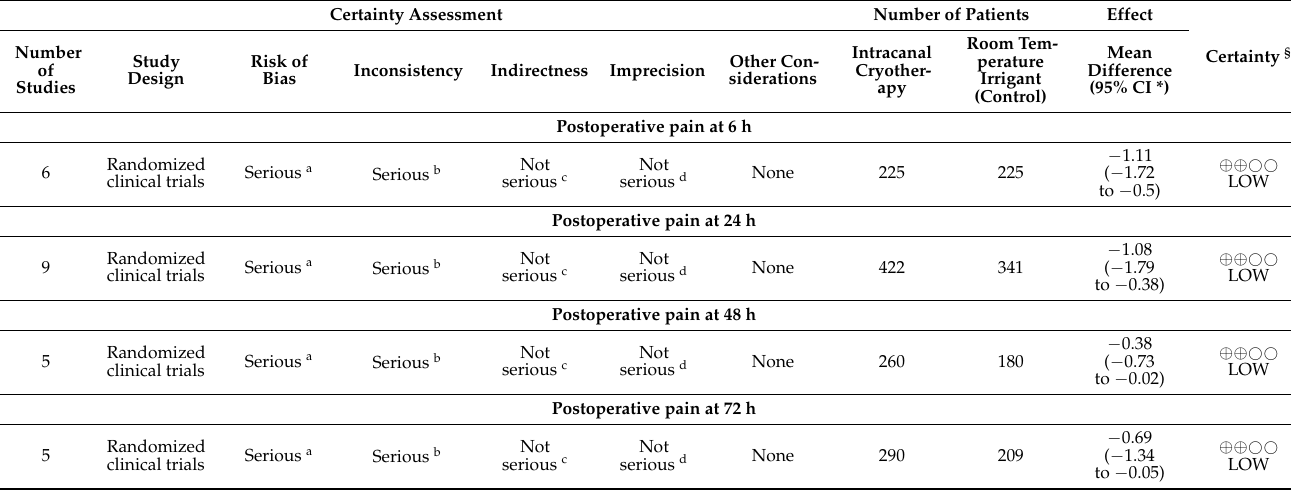
Table 2. Certainty of evidence. Question: Is intracanal cryotherapy effective in reducing postoperative endodontic pain compared with a room temperature irrigant (Control)?; Setting: A dental clinic; Participants: Adult patients ( ≥ 18 years old) with permanent teeth that have pulpal or periradicular pathosis; Intervention: Final irrigation with a cold irrigant; Comparator: Final irrigation with an irrigant at room temperature.